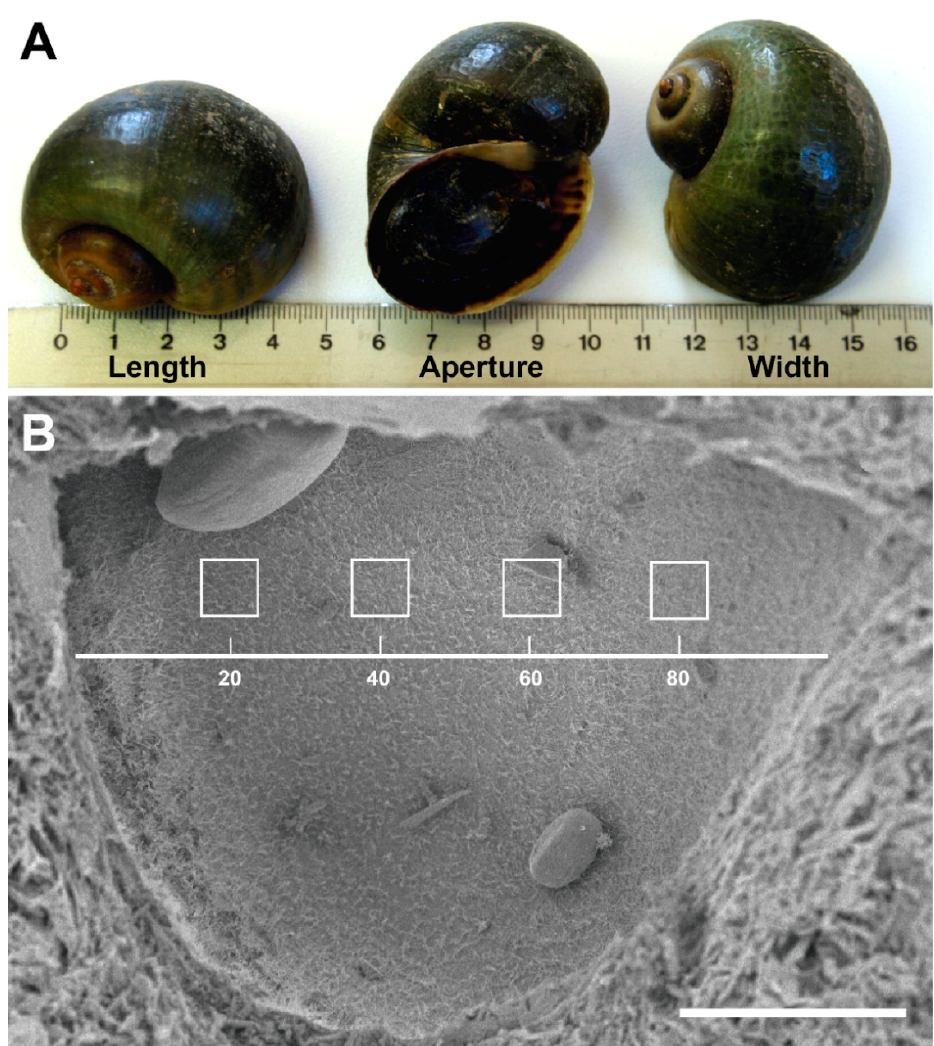
Figure 4. ( A ): Each individual of P. maculata was characterized through its shell dimensions (length, width and aperture length). ( B ): Hair cell bundle count locations (sampling squares) on the P. maculata statocyst. Hair cell counts were sampled at four predetermined locations: 20%, 40%, 60% and 80% of the total statocysts length. A 400 μ m 2 box was placed at each sampling area and hair cells were counted within each box. Scale bar: ( B ) = 100 μ m.